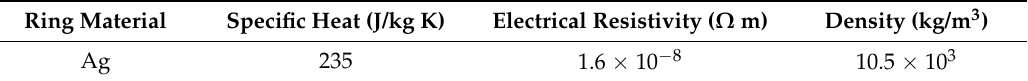
Table 2. Physical properties of silver (Ag) from [54].